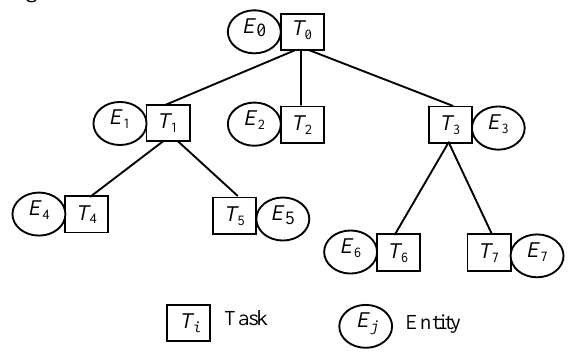
Fig. 1. Tighten coupling of